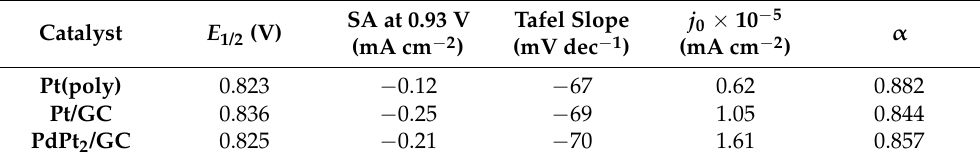
Table 2. Half-wave potential, specific activity, and kinetic parameters for ORR on Pt/GC